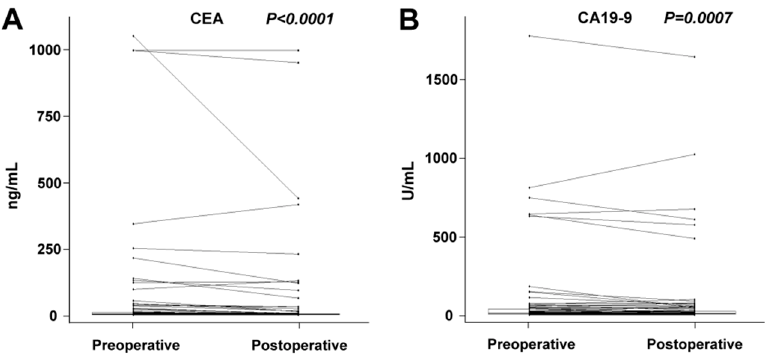
Figure 2. Comparison of paired preoperative and postoperative blood serum CEA ( A ) and CA19-9 ( B ) values in the group comprising all patients. Box-and-whisker plots with outliers shown as separately plotted points. Paired values are connected by a line. A statistically significant decrease was recorded for both CEA and CA19-9.